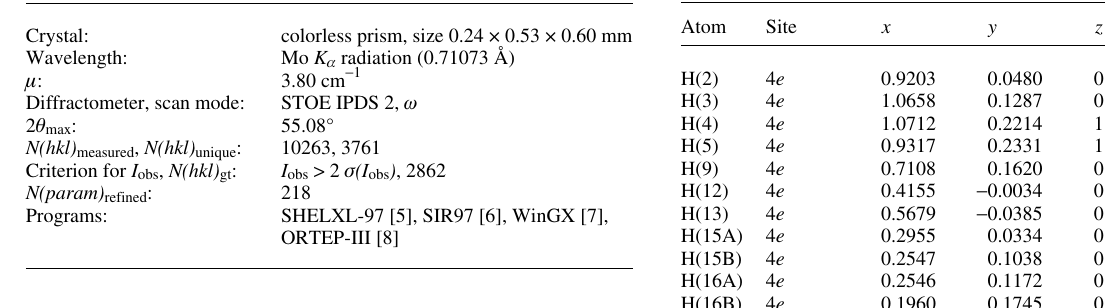
Table 2. Atomic coordinates and displacement parameters (in Å 2 ) . Table 1. Data collection and